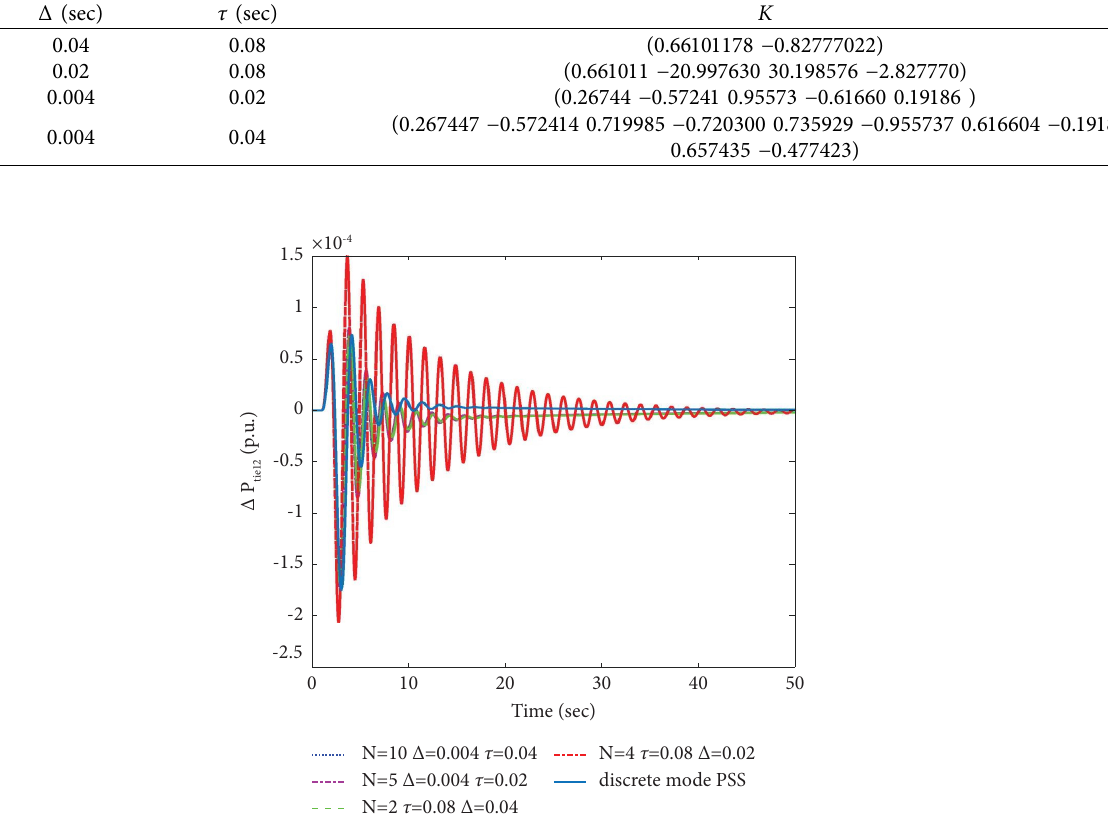
Figure 7: Tie line power deviation Δ P tie12 (p.u.) with respect to time (sec) with the discrete PSS and POF controller.